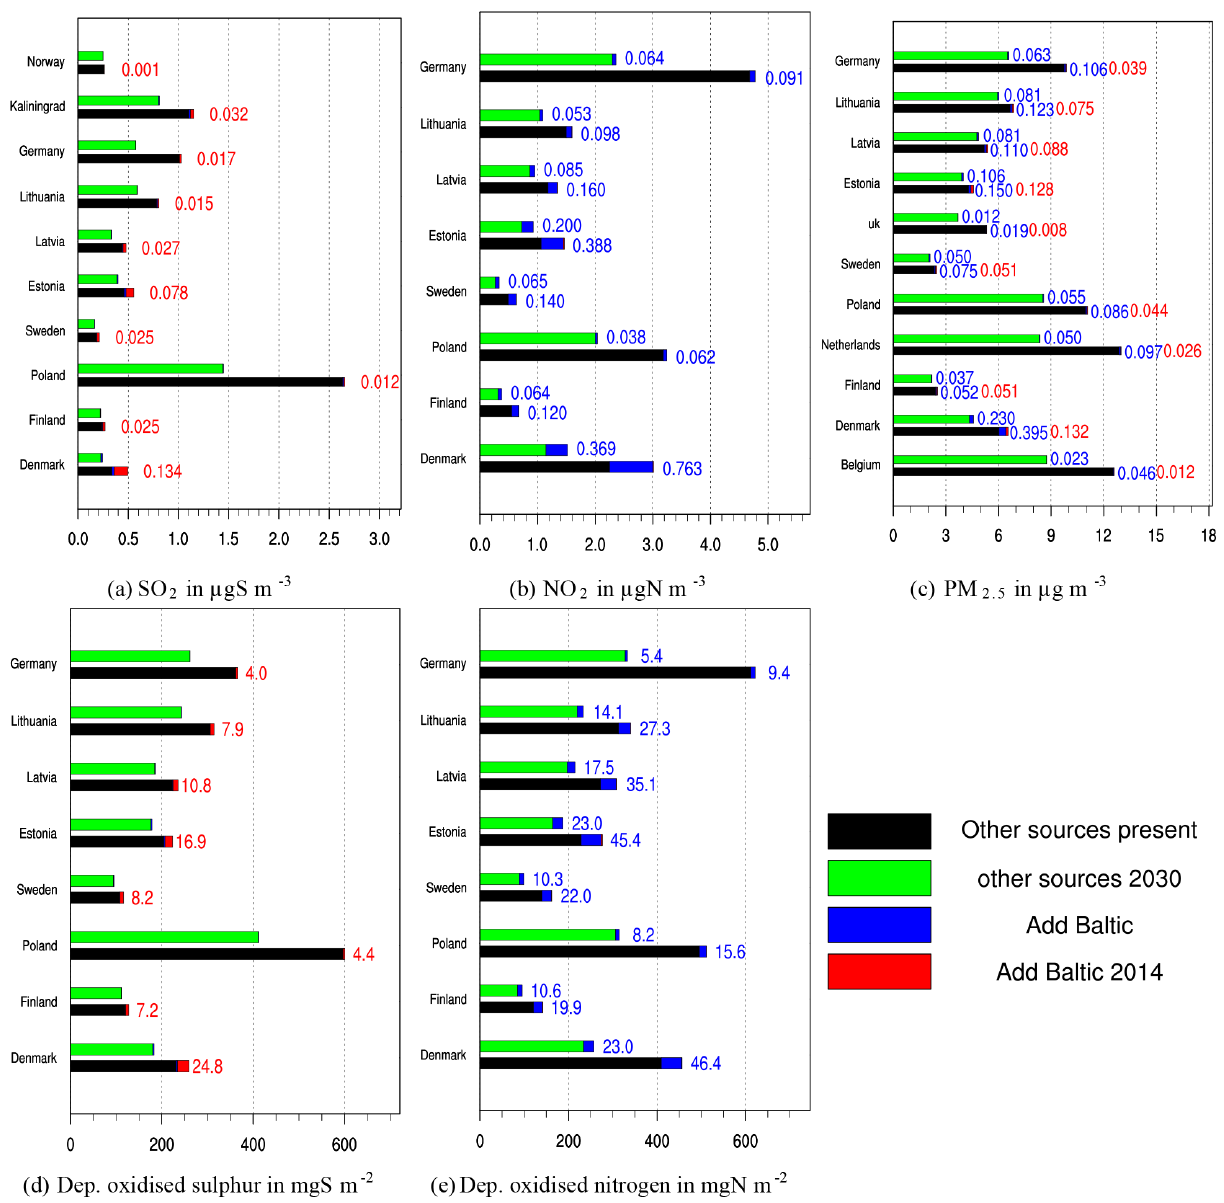
Figure 3. For each country, the upper bar shows the future (2030) case and the lower bar the present case country average concentration. (a) SO 2 , (b) NO 2 , (c) PM 2 . 5 , and depositions of oxidised sulfur (d) and oxidised nitrogen (e) . The black and green bars represent the Present_NoShip and Future_NoShip calculations, respectively. The additional contributions from BAS (Add Baltic) are shown in blue and the additional effect assuming high sulfur fuel emissions (Add Baltic 2014) in red. (These are also given as numbers. Numerical values for NO 2 Add Baltic 2014 and for SO 2 Add Baltic are not given as they are very